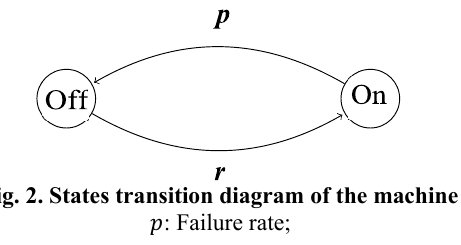
Fig. 2. States transition diagram of the